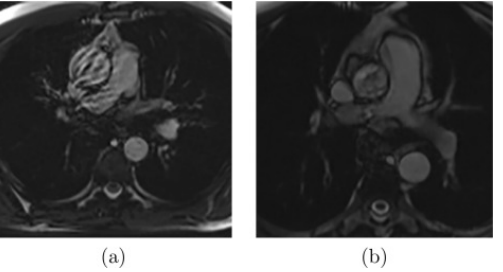
Figure 2. Examples of MR images with artifacts due to ( a ) rapid or ( b ) turbulent blood flow